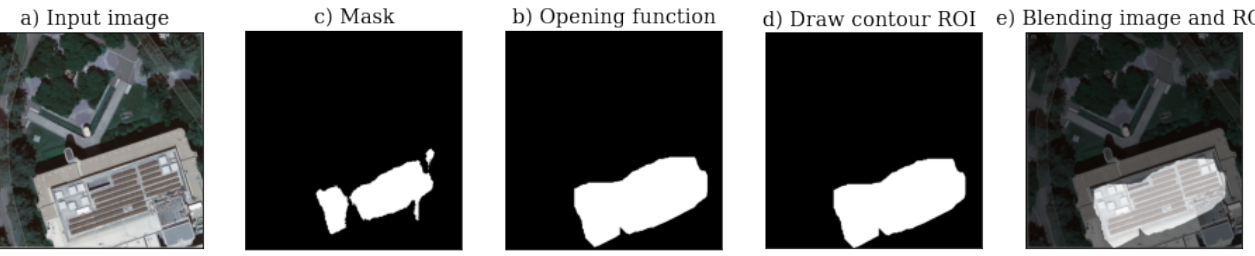
Figure 8. Steps of boundary extraction by DL server, and OpenCV functions in CSUSL PV